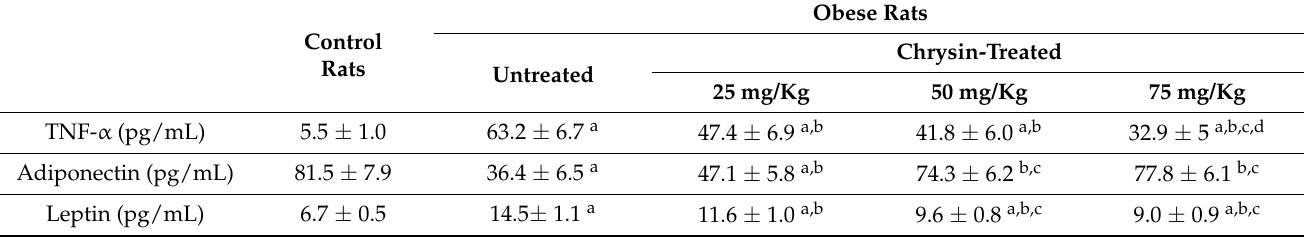
Table 3. Adipocytokines levels in control rats, obese untreated rates, and obese rats treated with different doses of